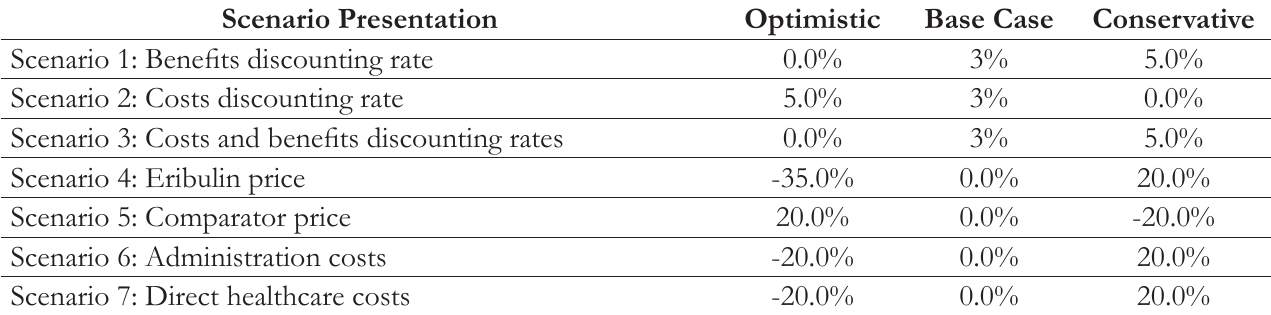
Table 7. Scenario